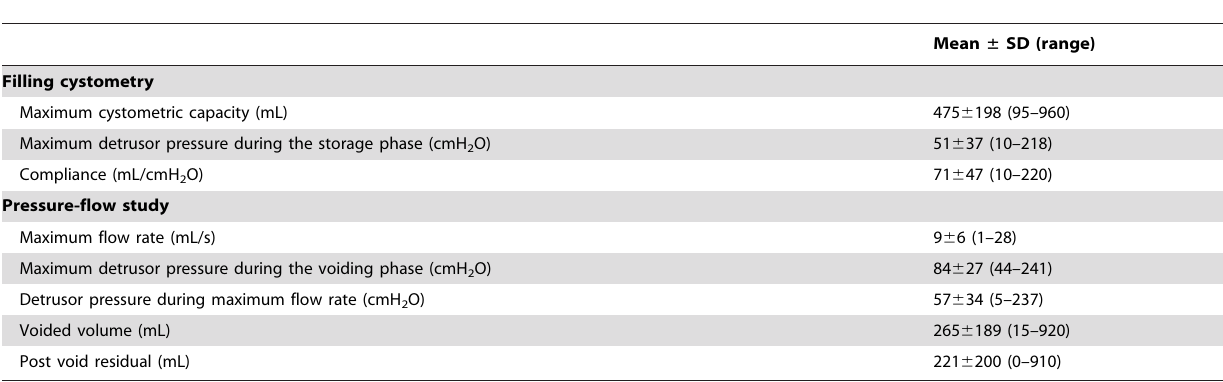
Table 1. Urodynamic parameters of the 72 patients included in the study.